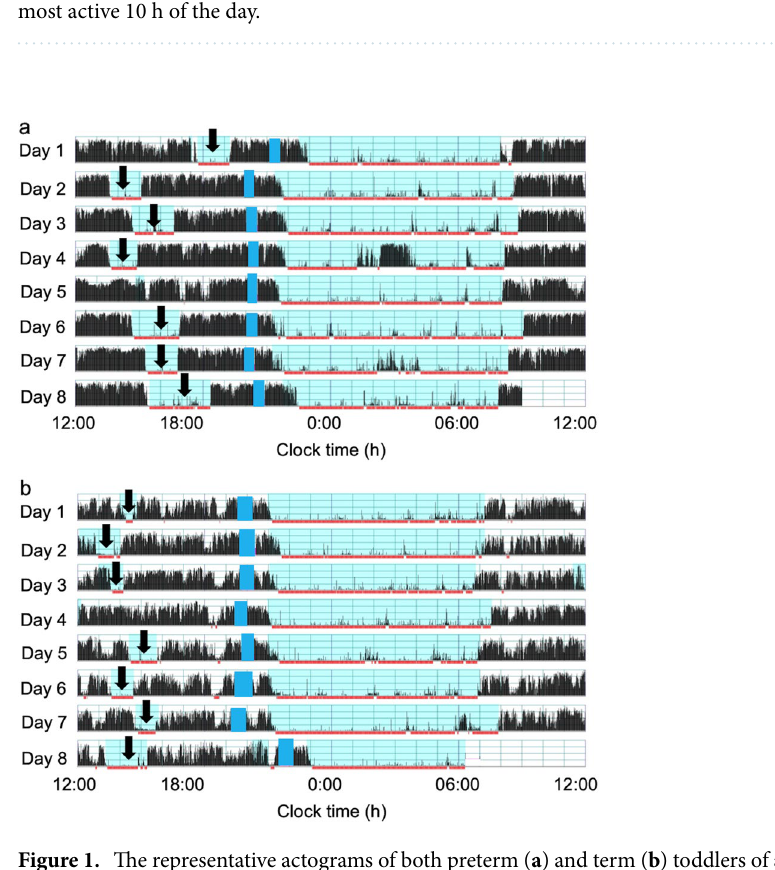
Table 3. Comparison of nonparametric sleep parameters between preterm and term toddlers (median (IQR)). IS: Interdaily stability, IV: Intradaily variability, L5 counts: activity counts of the least active 5 h of the day, M10 counts: activity counts of the most active 10 h of the day, RA: (M10 counts – L5 counts) / (M10 counts + L5 counts), L5 onset: activity onset time of the least active 5 h of the day, M10 onset: activity onset time of the most active 10 h of the day.